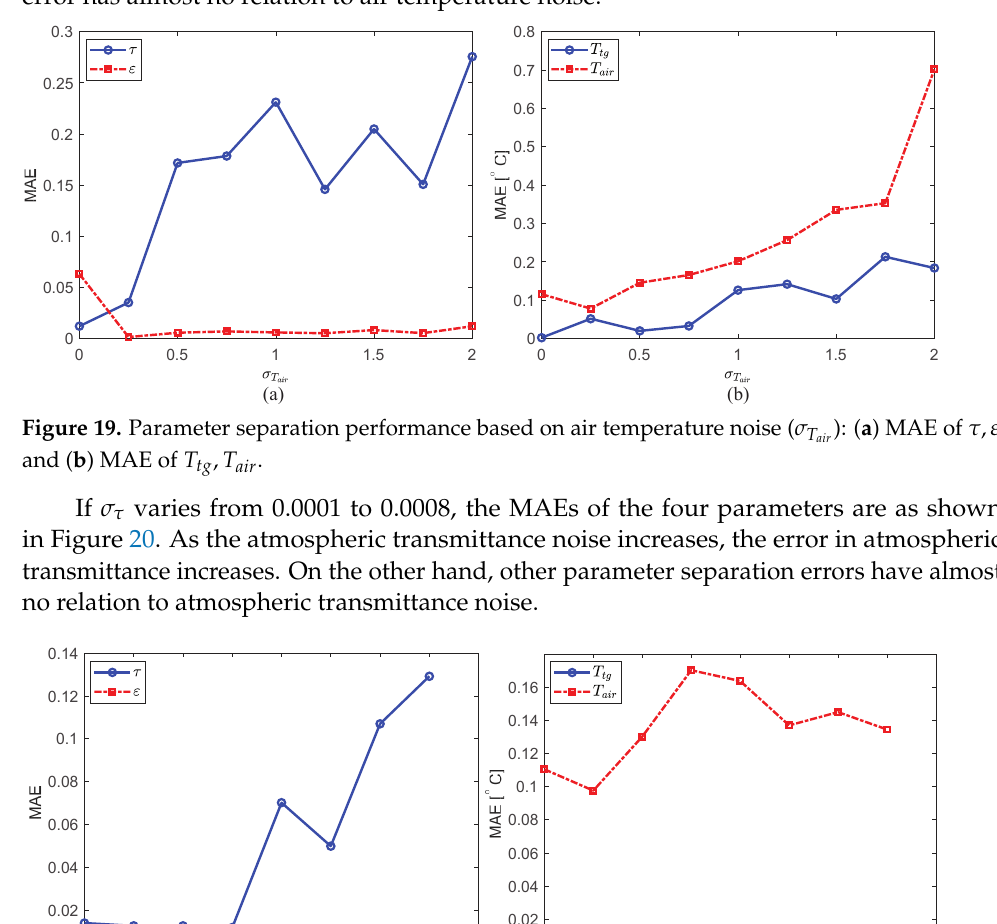
Figure 20. Parameter separation performance based on atmospheric transmittance noise ( σ τ ): ( a ) MAE of τ , ε , and ( b ) MAE of T tg , T air